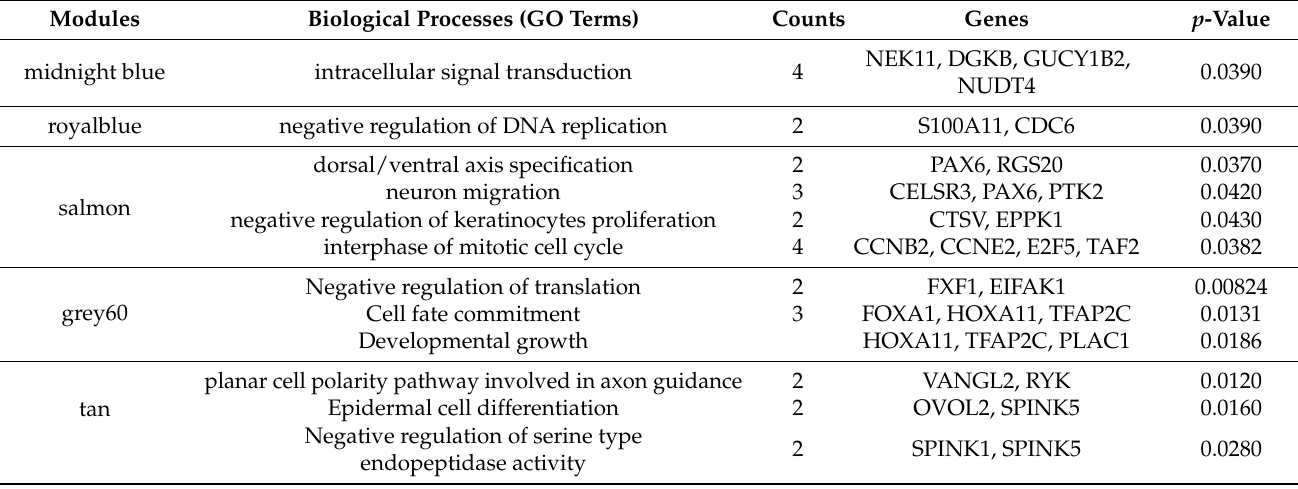
Table 3. Enriched biological processes associated with non-preserved modules identified from GBC network.